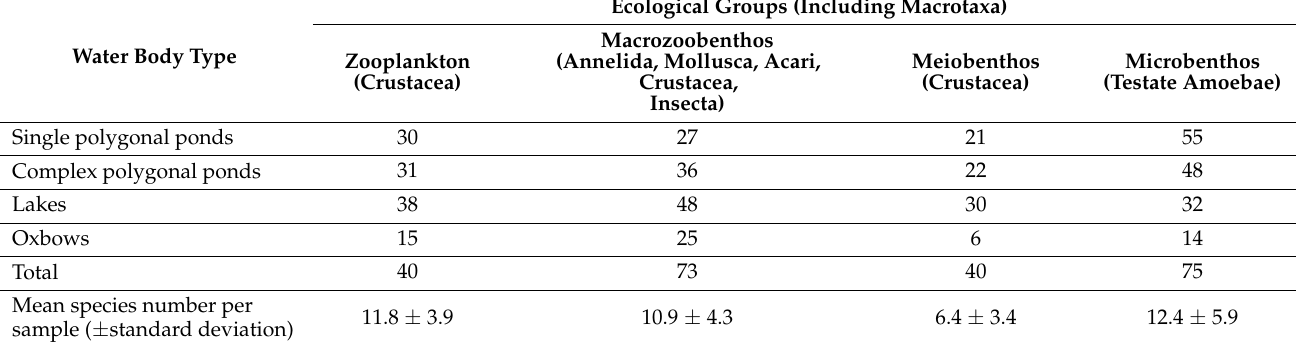
Table 1. The total species number of ecological groups in various types of water bodies in the Lena River